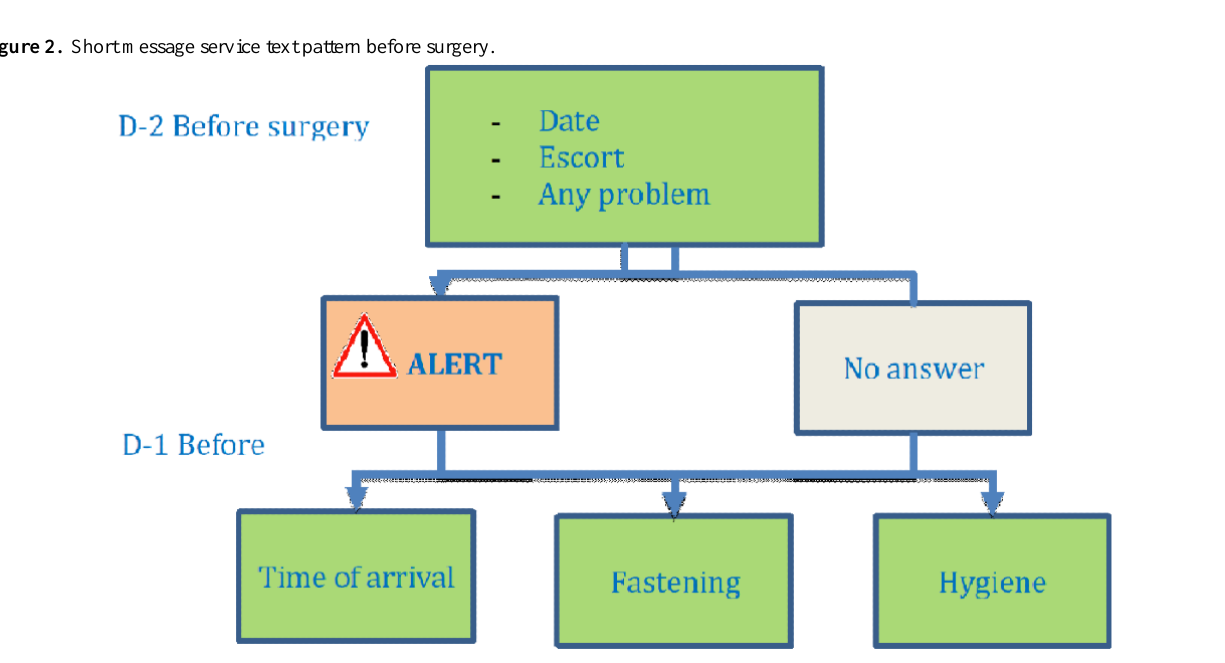
Figure 2. Short message service text pattern before